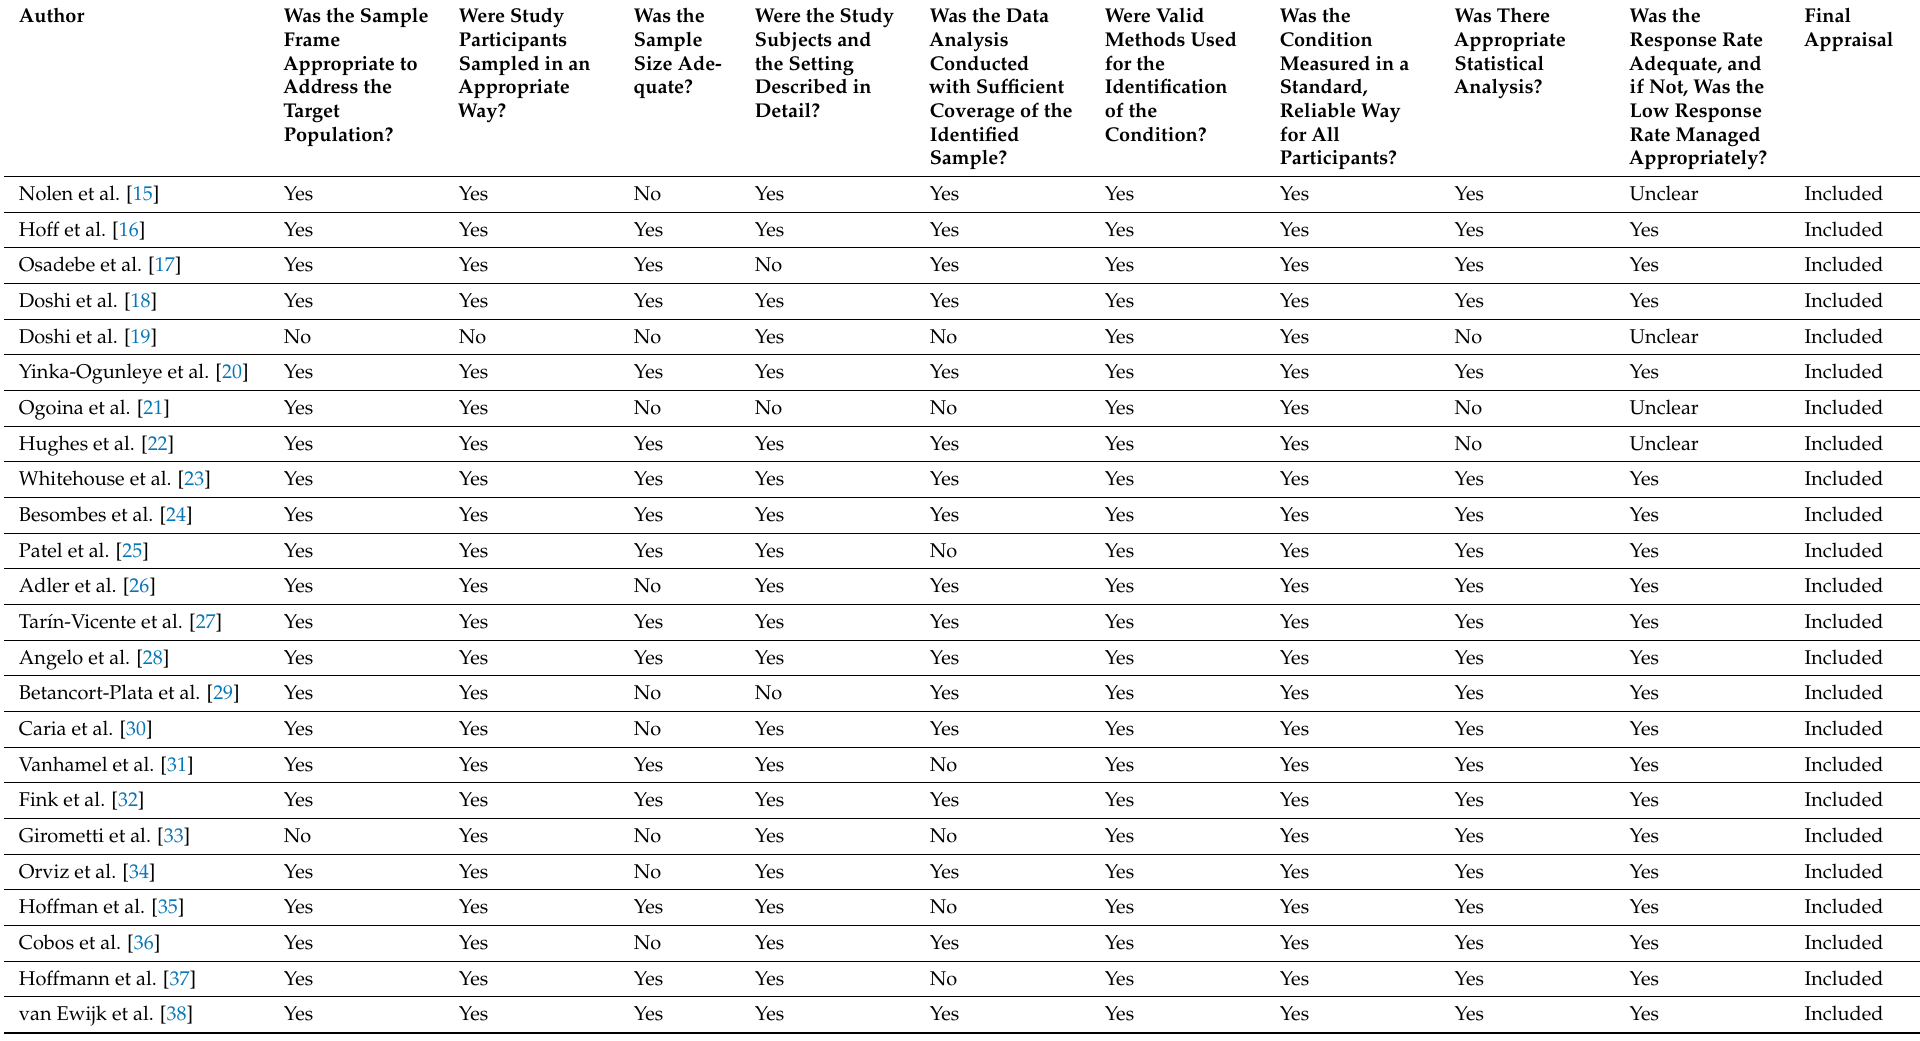
Table 1. Quality assessment of the cross-sectional studies included in the meta-analysis (the JBI